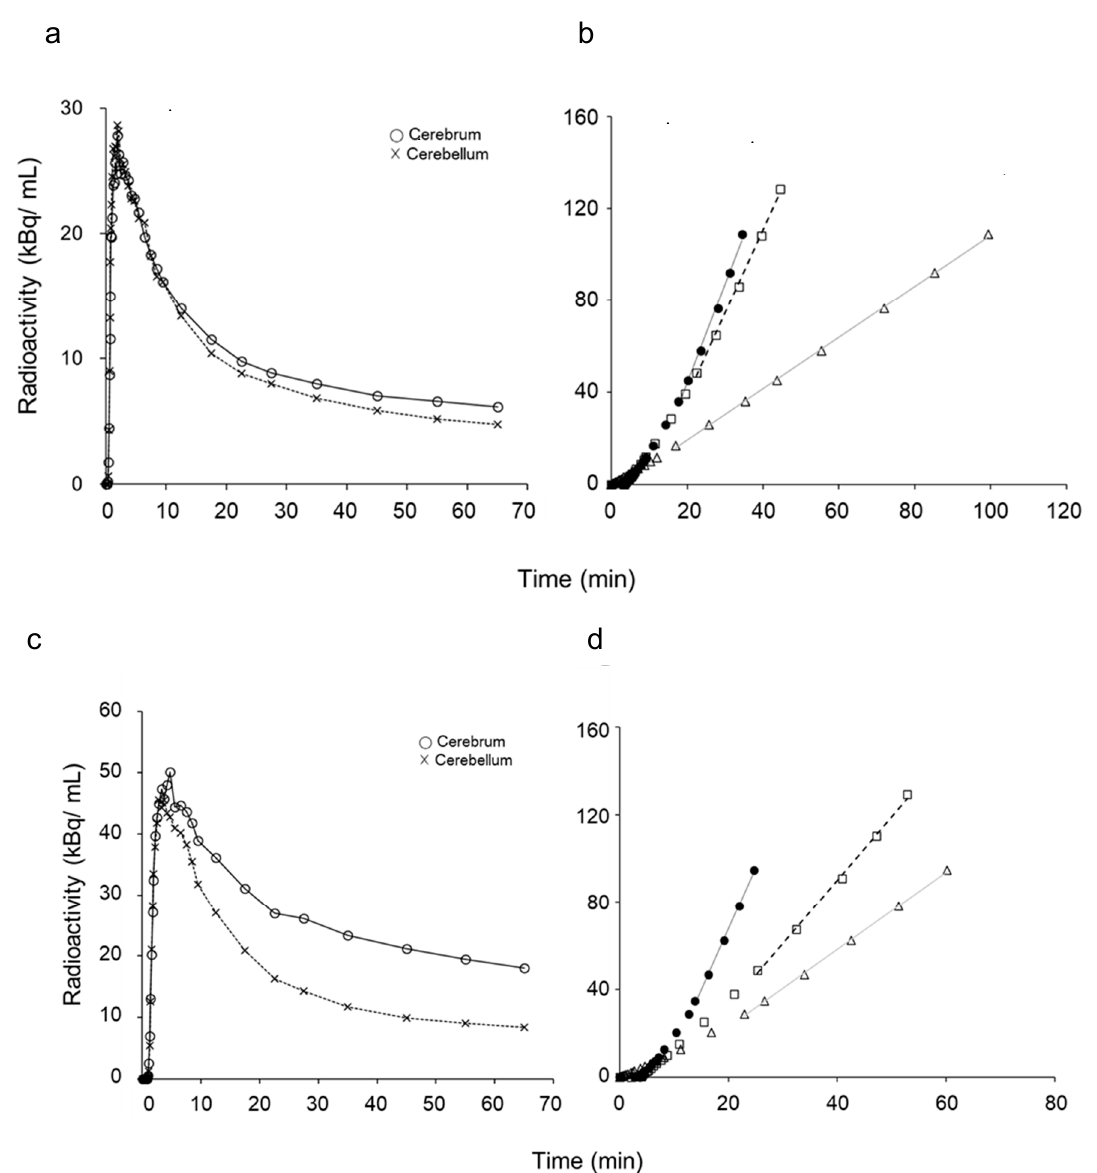
Figure 2. Representative cortical TACs of cerebrum ( ○ ) and cerebellum (×) obtained from dynamic PET data for each group of healthy control (CTL) ( a ) and early Alzheimer’s disease (eAD) subjects ( c ). Logan plots of [ 11 C]PiB PET show good linear correlations in the later phases of a control ( b ) and an AD patient ( d ). The slopes of the regression lines were significantly different between cerebral cortex ( ● and solid line) and cerebellum ( □ and dashed line) in AD patients ( d ), while they were similar in controls ( b ). The reference tissue graphical plot method also showed good linear correlations in the later phase ( △ and gray line), but the slopes were completely different from the Logan plots because the cerebellar TACs were used for distribution volume ratio (DVR) calculation.